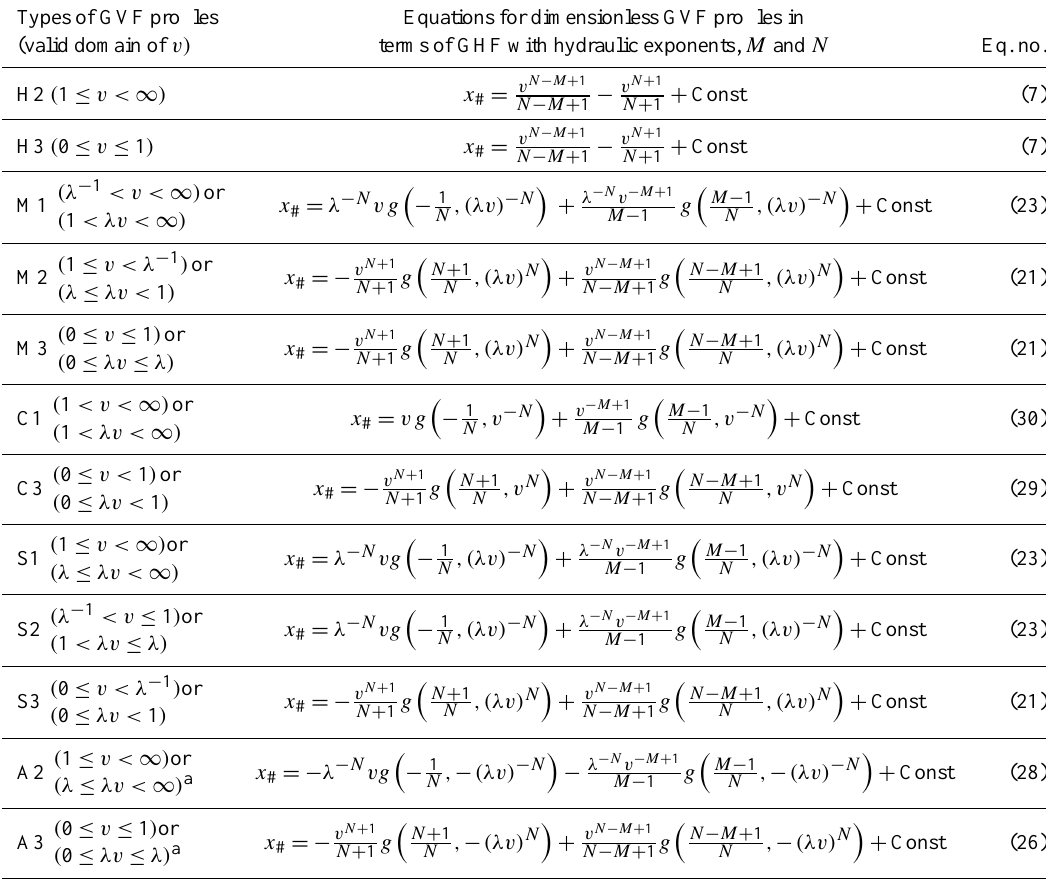
Table 1. The y c -based dimensionless GVF profiles expressed by using the GHF on all types of slopes except for the horizontal slope. Types of GVF profiles Equations for dimensionless GVF profiles in (valid domain of v) terms of GHF with hydraulic exponents, M and N Eq. no.